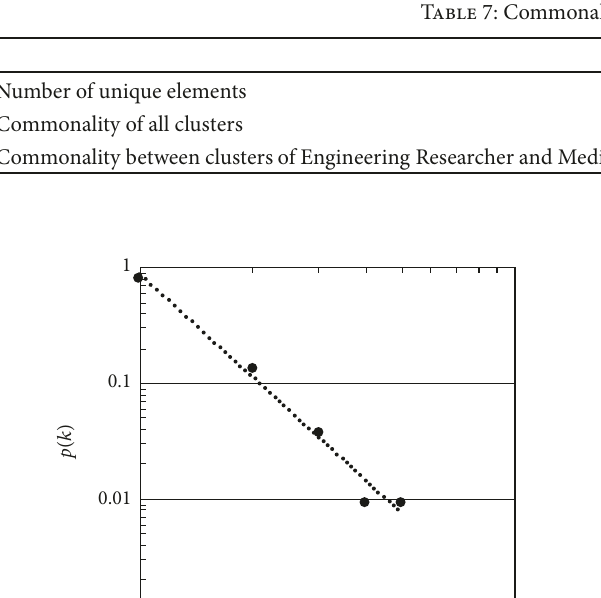
Figure 7 is the distribution of terms in the logarithmic